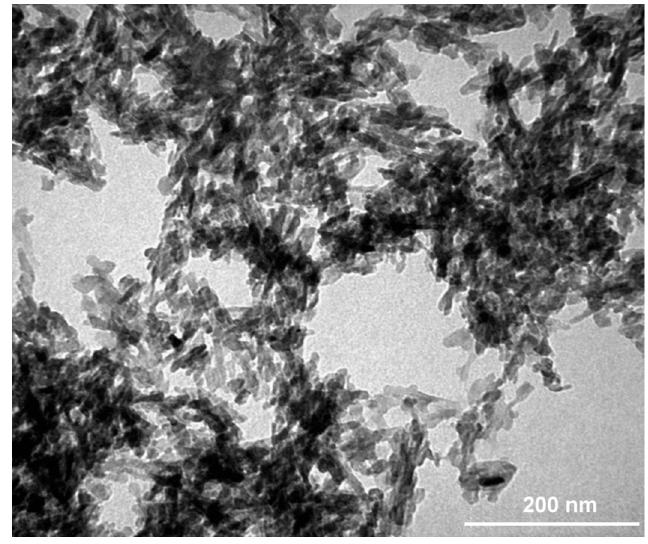
Figure 2. Transmission electron microscopy (TEM) image of n HA.